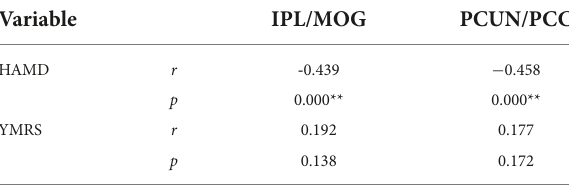
TABLE 3 Correlation analysis of dDC variability with manic/depressive symptoms in all patients with bipolar